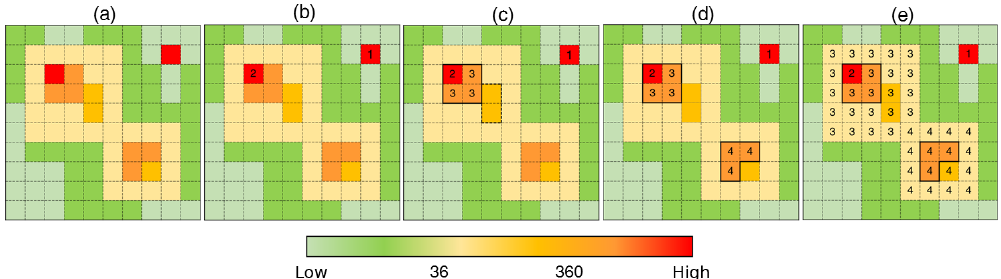
Figure 3. The processes of defining emission clumps. The colors qualitatively illustrate the emission rates from low (light green) to high (red). (a) The emission field. (b) Two power plants (red grid cells) are defined as two individual clumps, labeled 1 and 2. (c) The ESRI urban area is outlined by bold solid and dashed lines, but the ESRI core is labeled 3 only for grid cells with emission rates above threshold-1. (d) The orange area represents grid cells with emissions above threshold-1 forming a non-ESRI core, labeled 4. (e) Each light-yellow grid cell is assigned to one of the clump cores using the RW algorithm (see the main text). Note that one power plant (labeled 2) is located within the ESRI urban area but is identified as a different emission clump from the ESRI clump (labeled 3 in Fig. 3e).